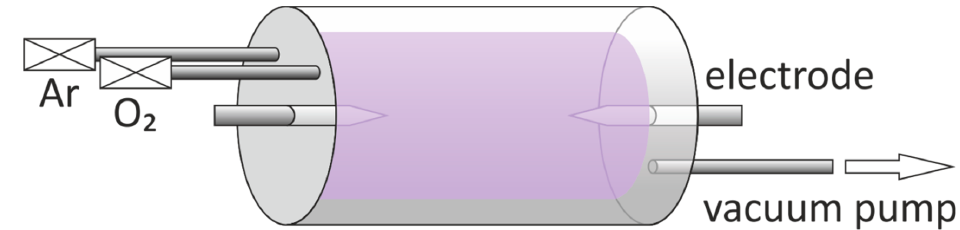
Figure 1. Schematic diagram of a custom-made plasma-enhanced horizontal tube furnace deposition system. The vacuum-sealed glass cylinder reactor has two electrodes with pointed ends from each side, and these two electrodes are used to ignite plasma.